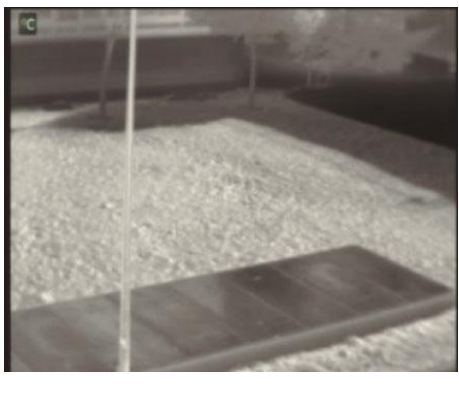
Figure 2. Environment for validating the robustness of the